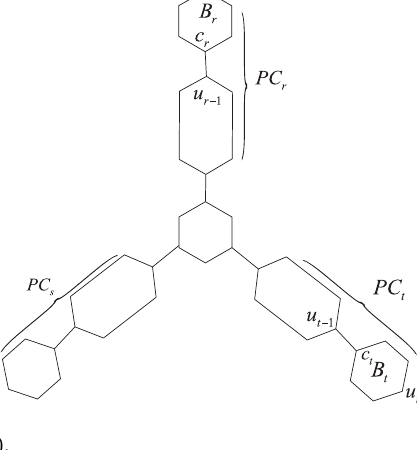
Figure 2: A polyphenyl spider PS ( r , s , t )